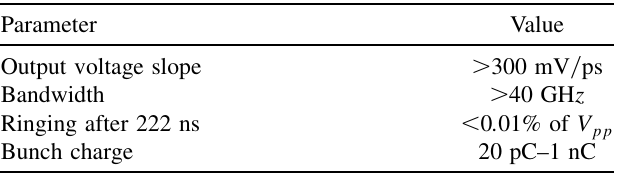
TABLE I. Design parameters and requirements.